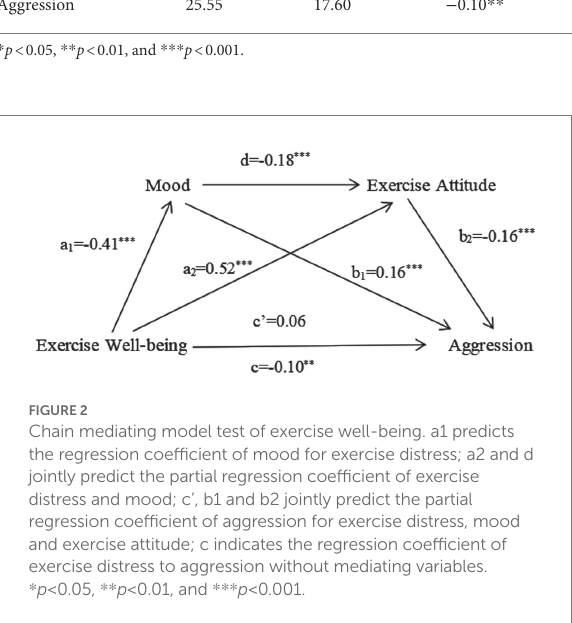
Exercise Mood Exercise Aggression distress attitude